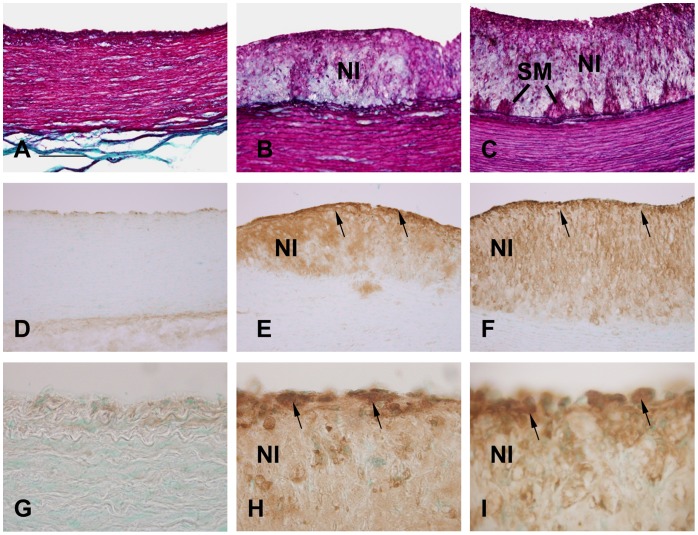
Histochemical and immunohistochemical staining of the aorta from rabbits exposed to stroke risk factors.A, D, G: Rabbits on normal diet. B, E, H: Hypercholesterolemia plus sham group. C, F, I: Hypertension plus hypercholesterolemia group. A-C: Aorta of rabbits stained by Masson’s Trichrome. Increased thickness of the neointima (NI) is seen in the hypercholesterolemia plus sham group (B, arrow). The changes are exacerbated in the hypertension plus hypercholesterolemia group (C, arrow). SM = smooth muscle cells in the neointima. D, E, F: Aorta of rabbits immunostained with a mouse monoclonal antibody to HNF-4A. Very little or no labeling is present in normal rabbits, but dense staining is observed in endothelial cells in the hypercholesterolemia plus sham, and hypertension plus hypercholesterolemia rabbits (arrows). G, H,I: Higher magnification of the aorta of rabbits immunostained with mouse monoclonal antibody to HNF-4A, showing dense staining in endothelial cells of hypercholesterolemia plus sham, and hypertension plus hypercholesterolemia rabbits (arrows). Scale: A-F = 200 µm, G-I = 70 µm.